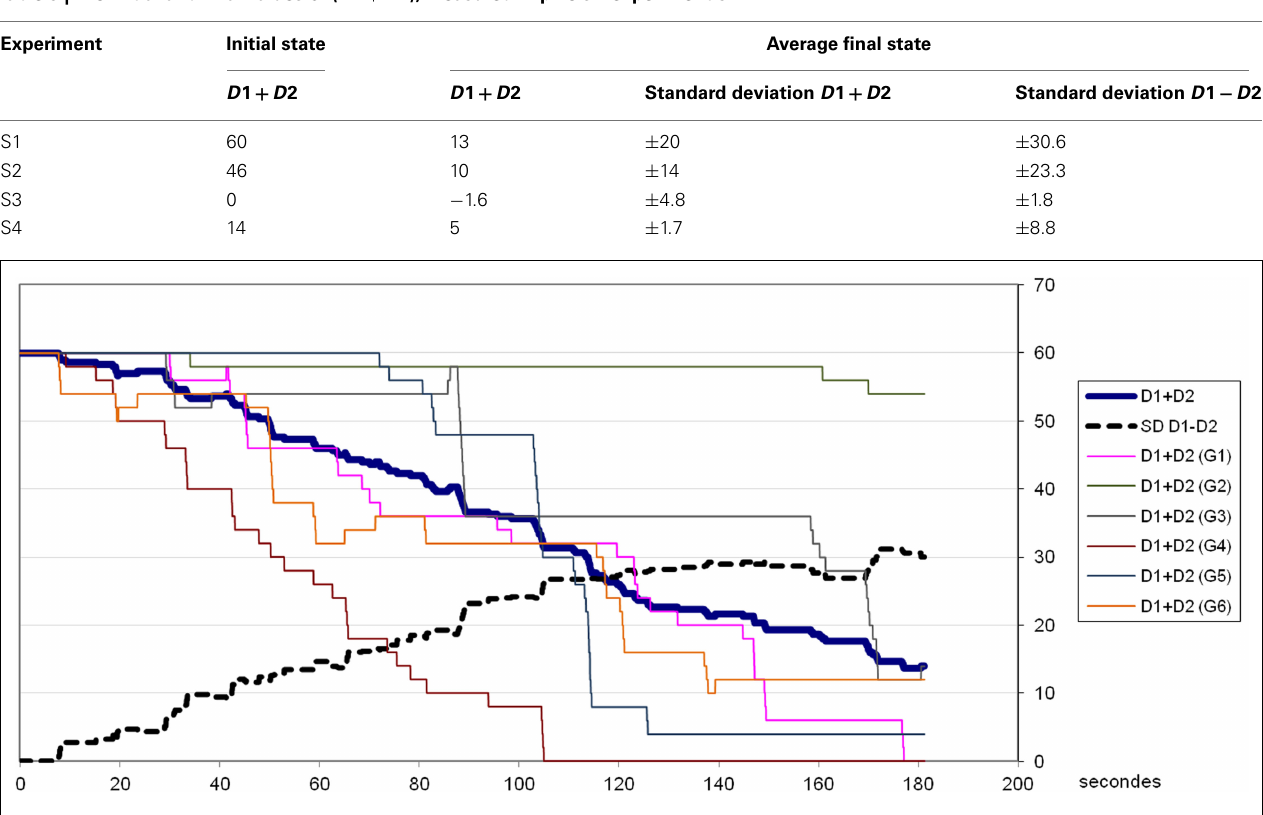
FIGURE 8 | Results of the first experimental session – experiment 3. Legend.The fine lines represent the evolution of ( D 1 + D 2), i.e., the distance between the body-objects of the six pairs of subjects, over the course of the